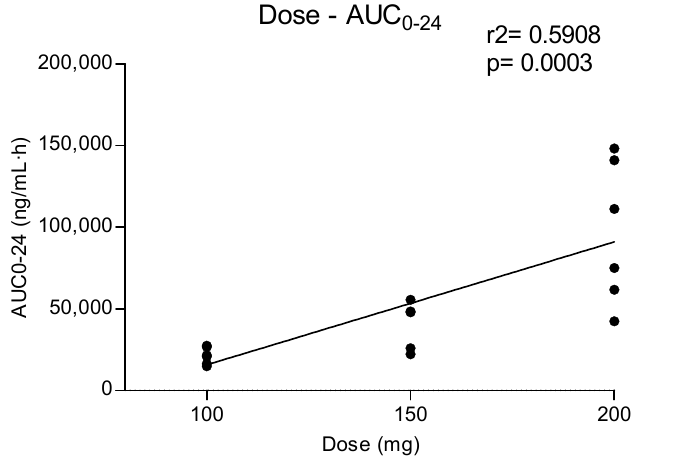
Figure 3. Relationship between administered methylone doses (100, 150 and 200 mg) and obtained AUC 0–24.